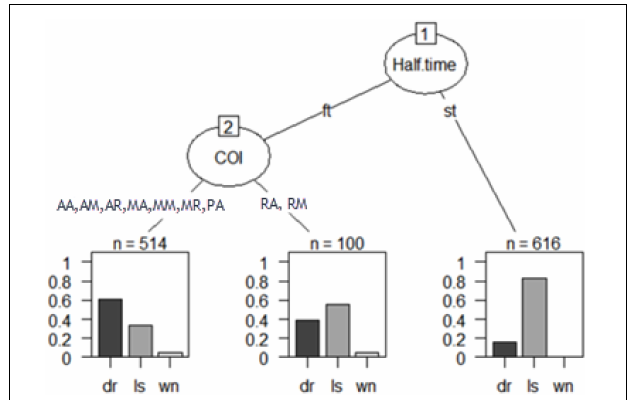
FIGURE 1 | Decision tree: unsuccessful teams graph.